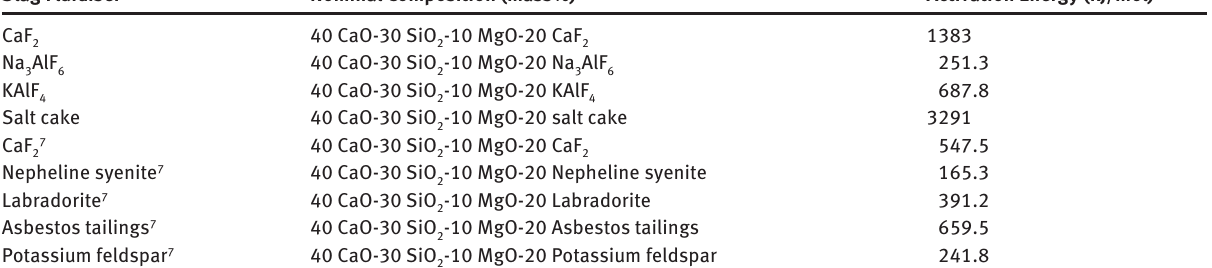
Table 3: Activation energy and nominal composition of slags with different fluidisers.